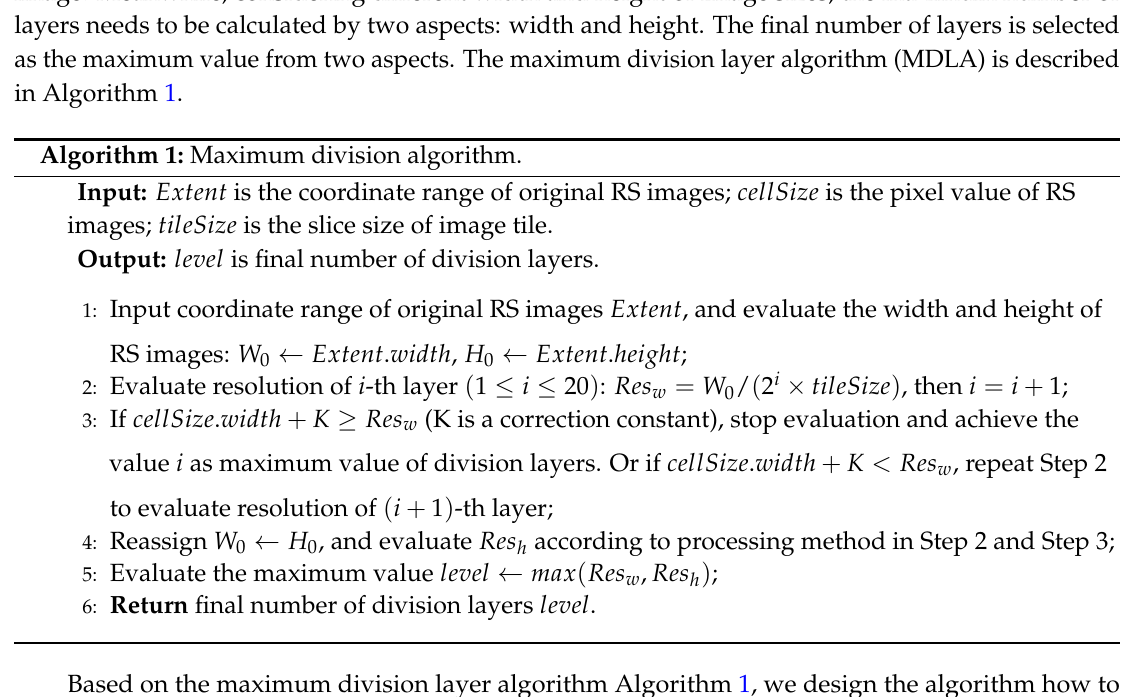
Algorithm 1: Maximum division